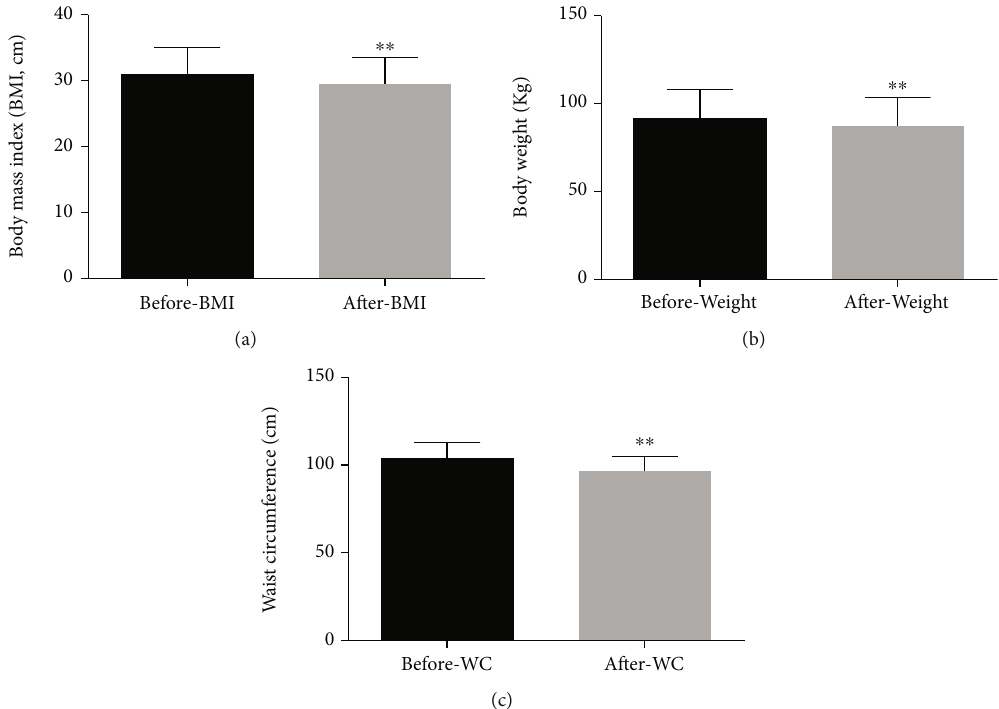
Figure 2: After liraglutide treatment, the weight, waist circumference (WC), and BMI decreased ( ∗∗ p < 0 : 01